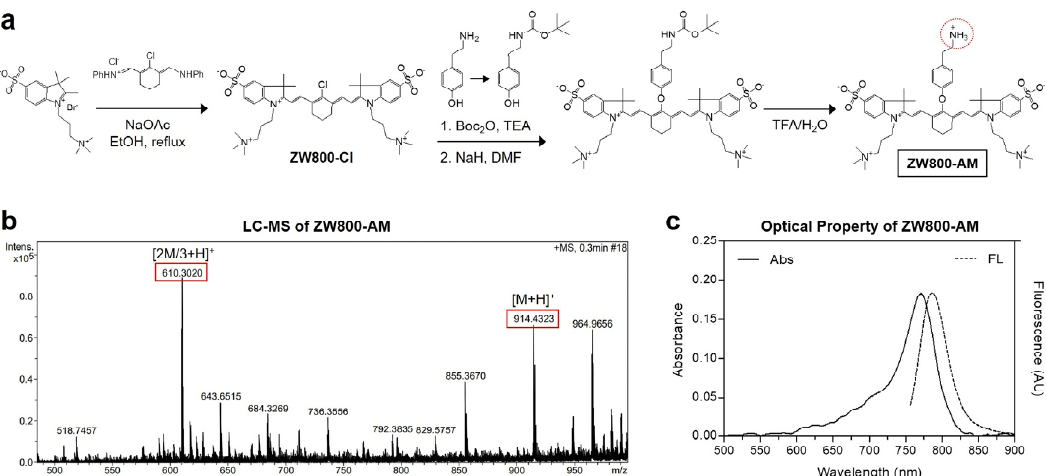
Figure 2. ( a ) Synthesis scheme, ( b ) mass spectrum, and ( c ) absorbance and fluorescence emission spectra of ZW800-AM NIR fluorophore. Optical measurements are performed in PBS at pH 7.4.